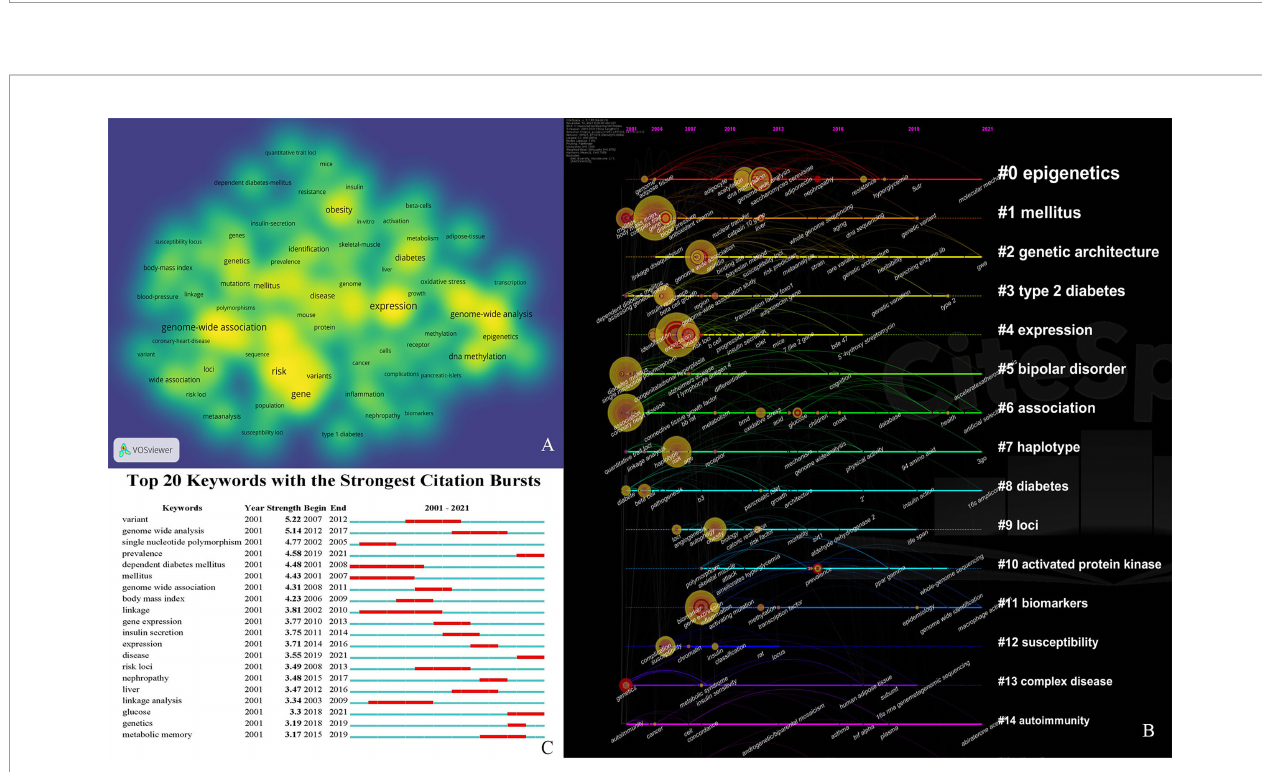
FIGURE 5 | (A) The co-occurrence network of the most frequently occurred 40 keywords in fi eld of GWAS in diabetes. Node size refers to number offrequency. (B) Timeline view of cluster for keywords co-occurrence in path fi nder pruning. Each cluster is named by most frequently occurred keyword. The clusters were arranged vertically in the descending order of their size (the smallest number refers to the largest cluster). The position and size of the node on the timeline reveal the cumulative frequency, and the year for the fi rst occurrence of each keyword, respectively. Nodes with red tree rings refer to keywords with citation bursts. (C) Top 20 keywords with the strongest citation bursts. The red bar refers to the burst duration. The burst strength indicates the importance of the keyword to the research fi eld.